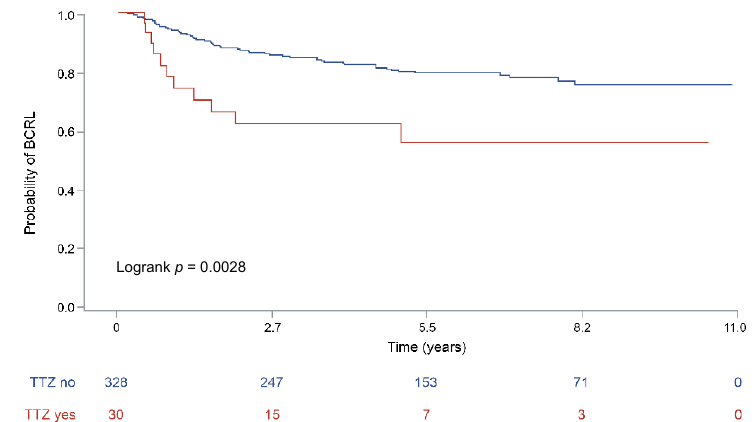
Figure 2. Lymphedema-free survival of the patients included in the study according to the administration of anti-human epidermal growth factor receptor 2 (HER2) therapy. The curves are built according to the by Kaplan-Meier method, p values are the expression of Log-rank test. The specific risk for a given timeframe is reported on the bottom of each graph. BCRL, breast cancer related lymphedema; TTZ, trastuzumab.